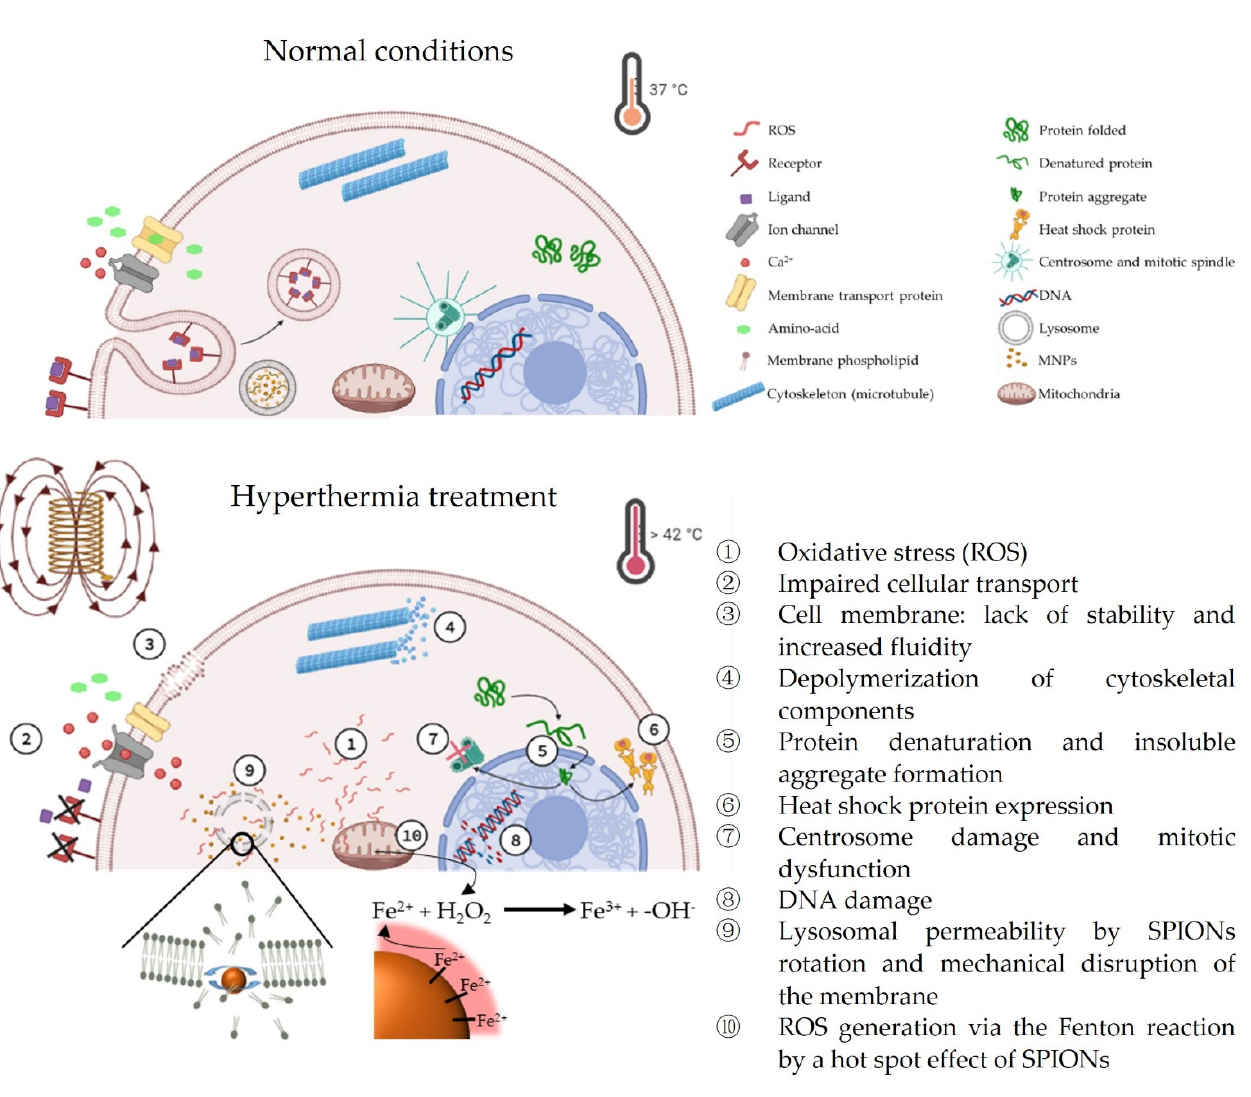
Figure 3. Cellular and sub-cellular biological effects derived from hyperthermia. Upper: normal conditions (37 °C) . Bottom: hyperthermia treatment (>42 °C).